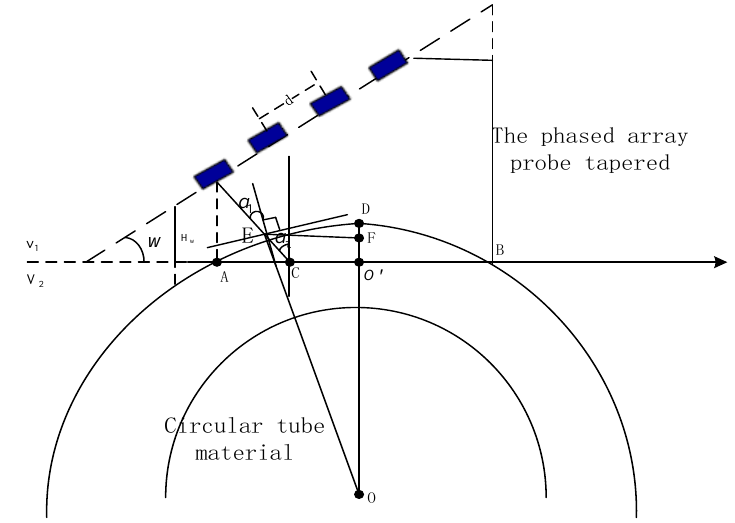
Figure 6. Schematic of the wedge after grinding.